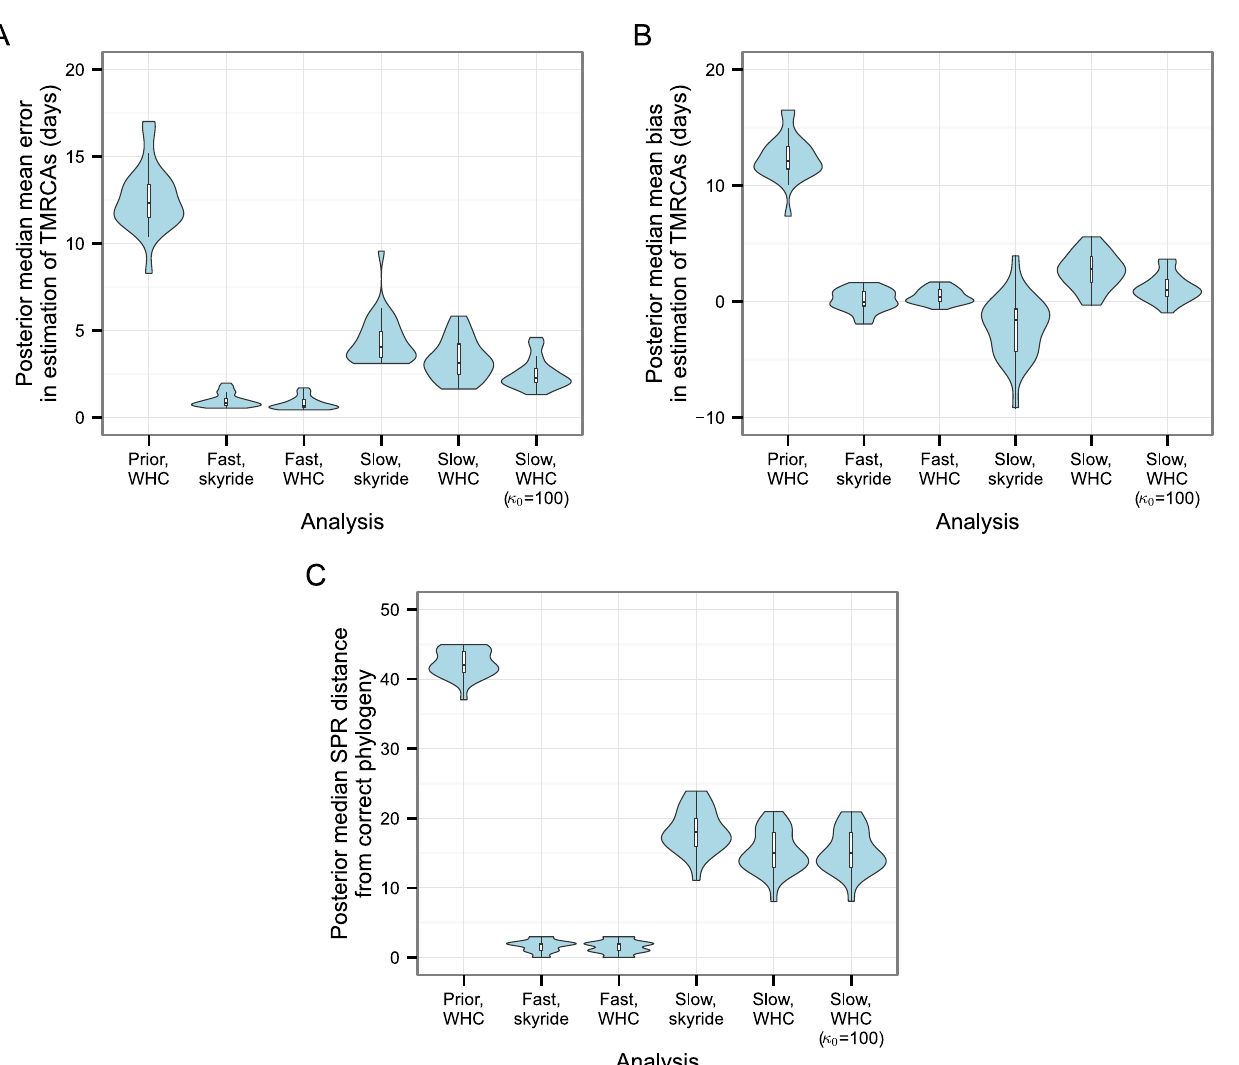
Fig 4. Accuracy of the reconstruction of the phylogeny. Each violin plot represents the density of a statistic calculated from the results of separate analyses of 25 simulated datasets; the clock model used to generate the dataset and the analysis method are indicated on the y -axis. (A) posterior median of mean bias in estimation of all pairwise TMRCAs. (B) posterior median of mean error in estimation of all pairwise TMRCAs. (C) Posterior median SPR distance from the true